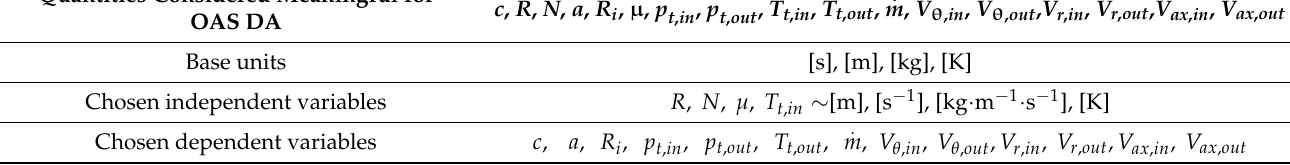
Table 1. Selection of quantities applied for Dimensional Analysis of OAS. Quantities Considered Meaningful